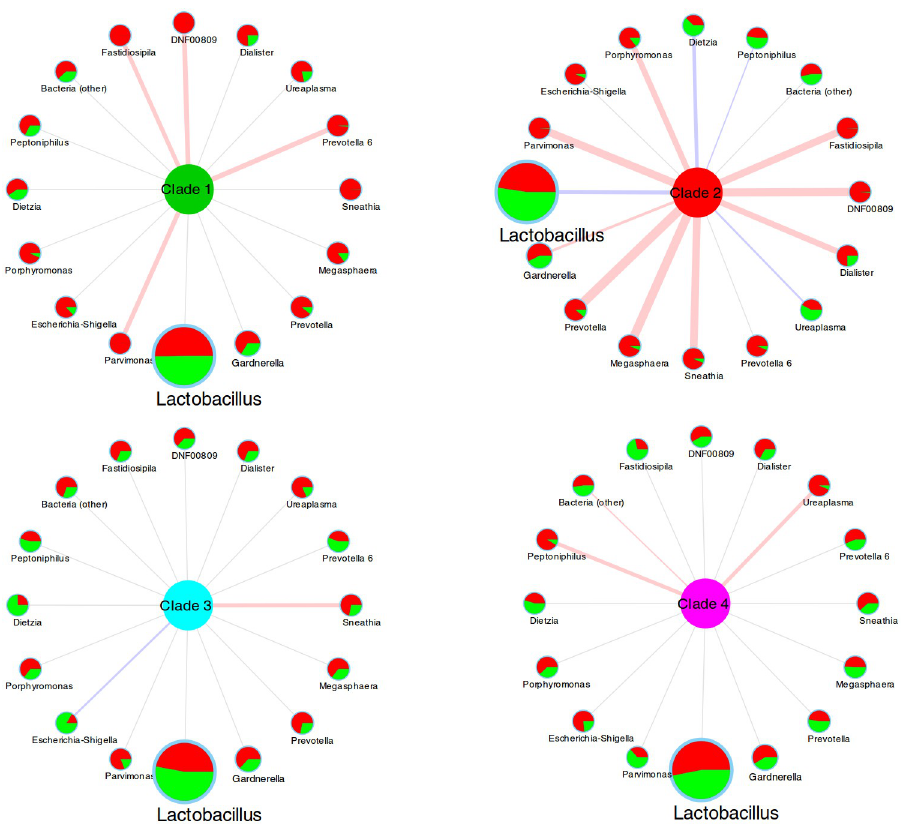
Fig 3. Diagram representing the correlations between bacterial genera and presence/absence of each of the four GV clades. Edge color represents the sign of the correlation (blue = negative, red = positive, gray = not significant) and edge thickness represents the strength of correlation. Node and label size of the bacterial genera is proportional to the average abundance over the whole set of samples. Piecharts in each node represent the skewness of the average relative abundance of the genera in samples not showing (green) or showing (red) the specific clade. Thus, for example, genera with a piechart nearly completely red are those whose abundance in the samples is more associated with positivity for the specific clade. Data used for building the figure are provided in S4